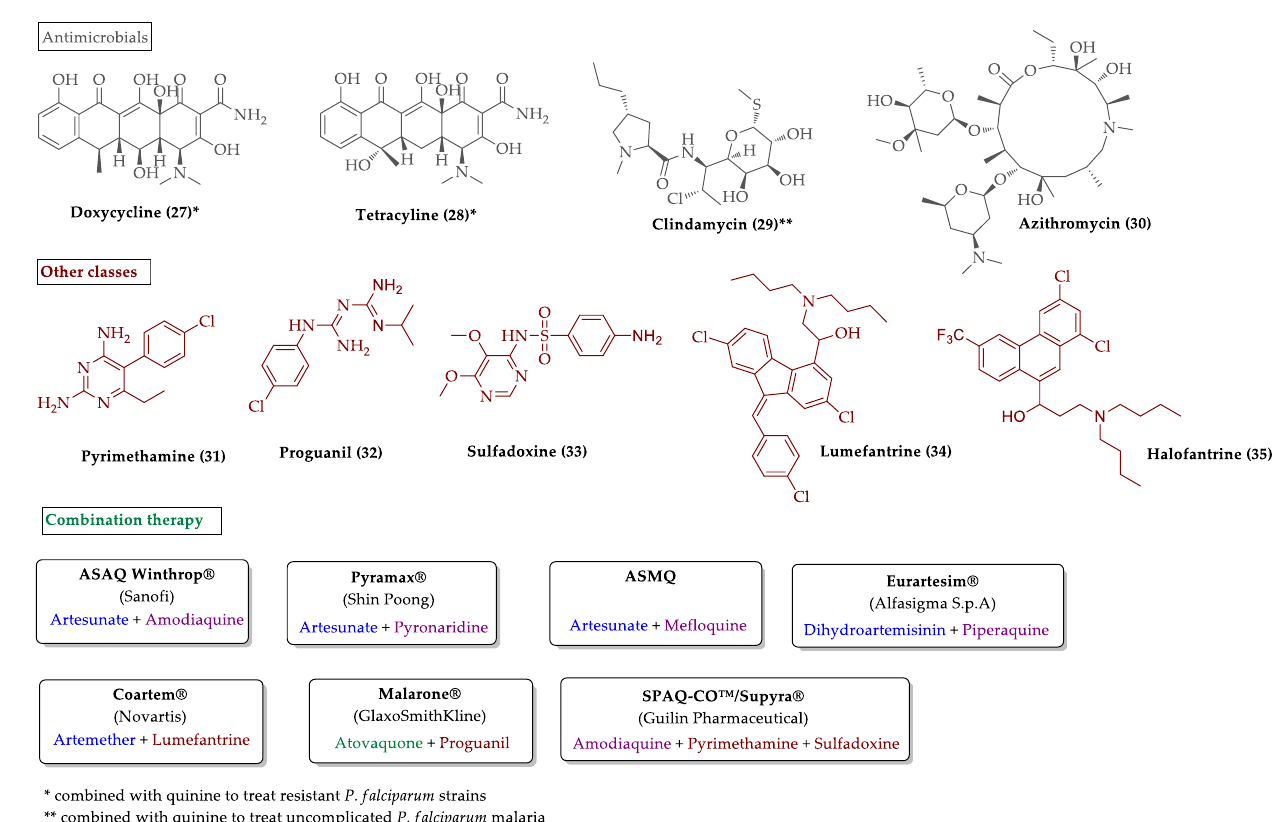
Figure 4. Antimalarial drugs and combination therapies in clinical use.